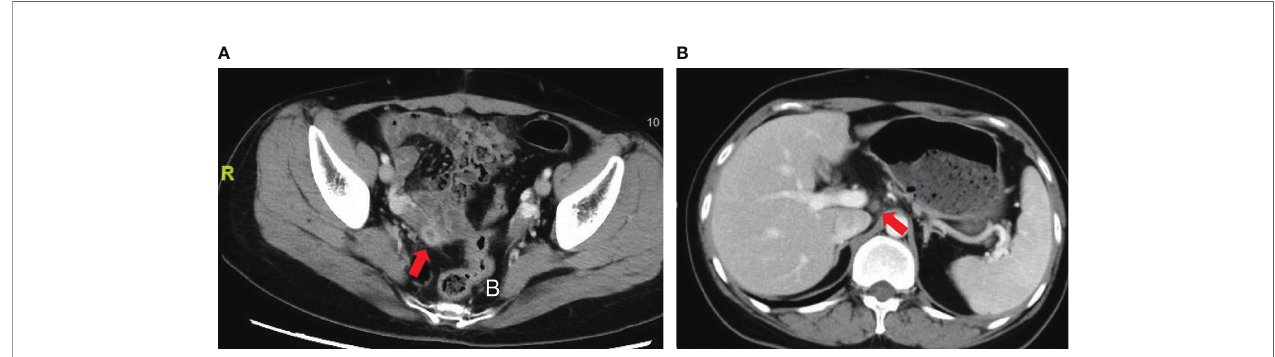
FIGURE 3 | Computed tomography (CT) scan of patient with YST originating from the broad ligament. (A) A 2-cm mass at the right pelvis; (B) Slightly enlarged